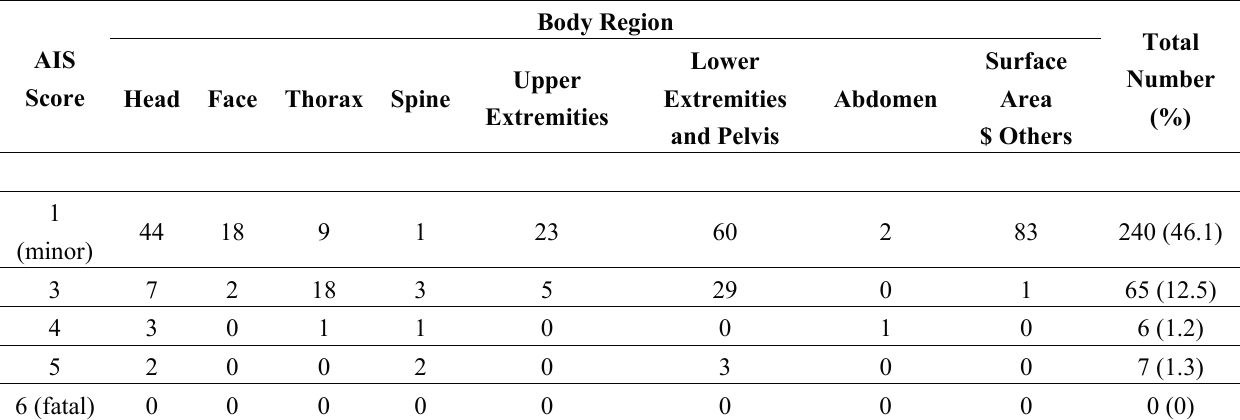
Table 4. Injury severity by body region of 521 injury diagnoses in admitted patients with earthquake-related